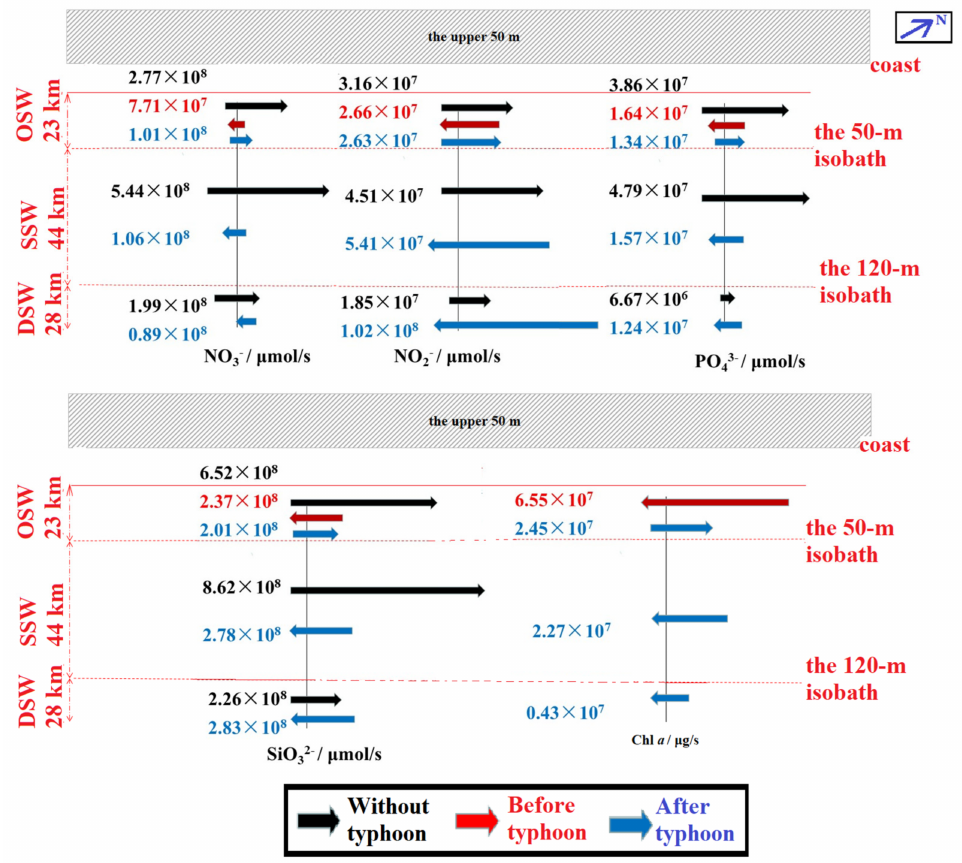
Figure 10. Diagram of nutrient fluxes in the upper 50 m.